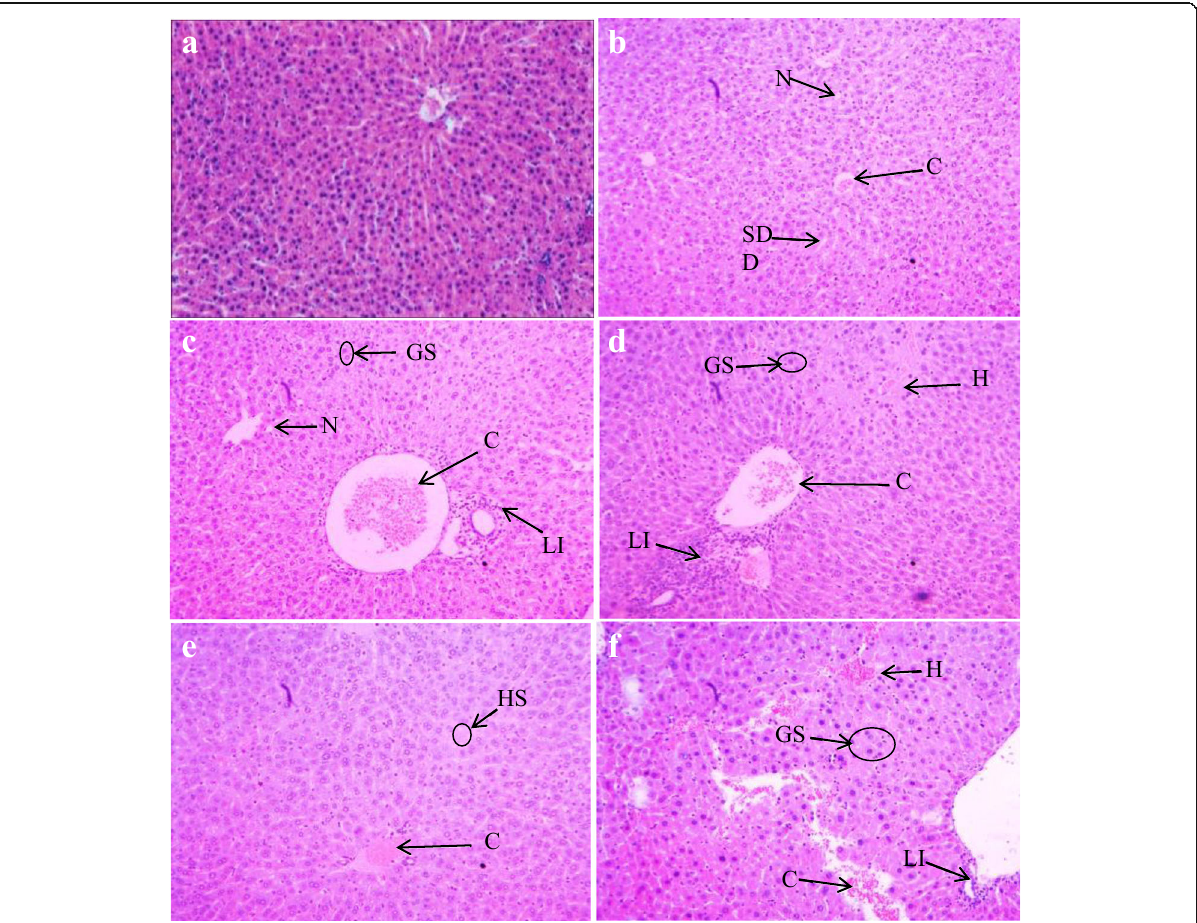
Fig. 1 Liver histology after 24 h of treatment. Both male and female mice were treated with low and high doses of THJ-2201. a Control liver section from mice treated with a vehicle. b , c Liver of male and female mice treated with low dose. d Liver of female mice treated with 50 mg/kg/bw. e , f Liver of male and female treated with high dose (HE,